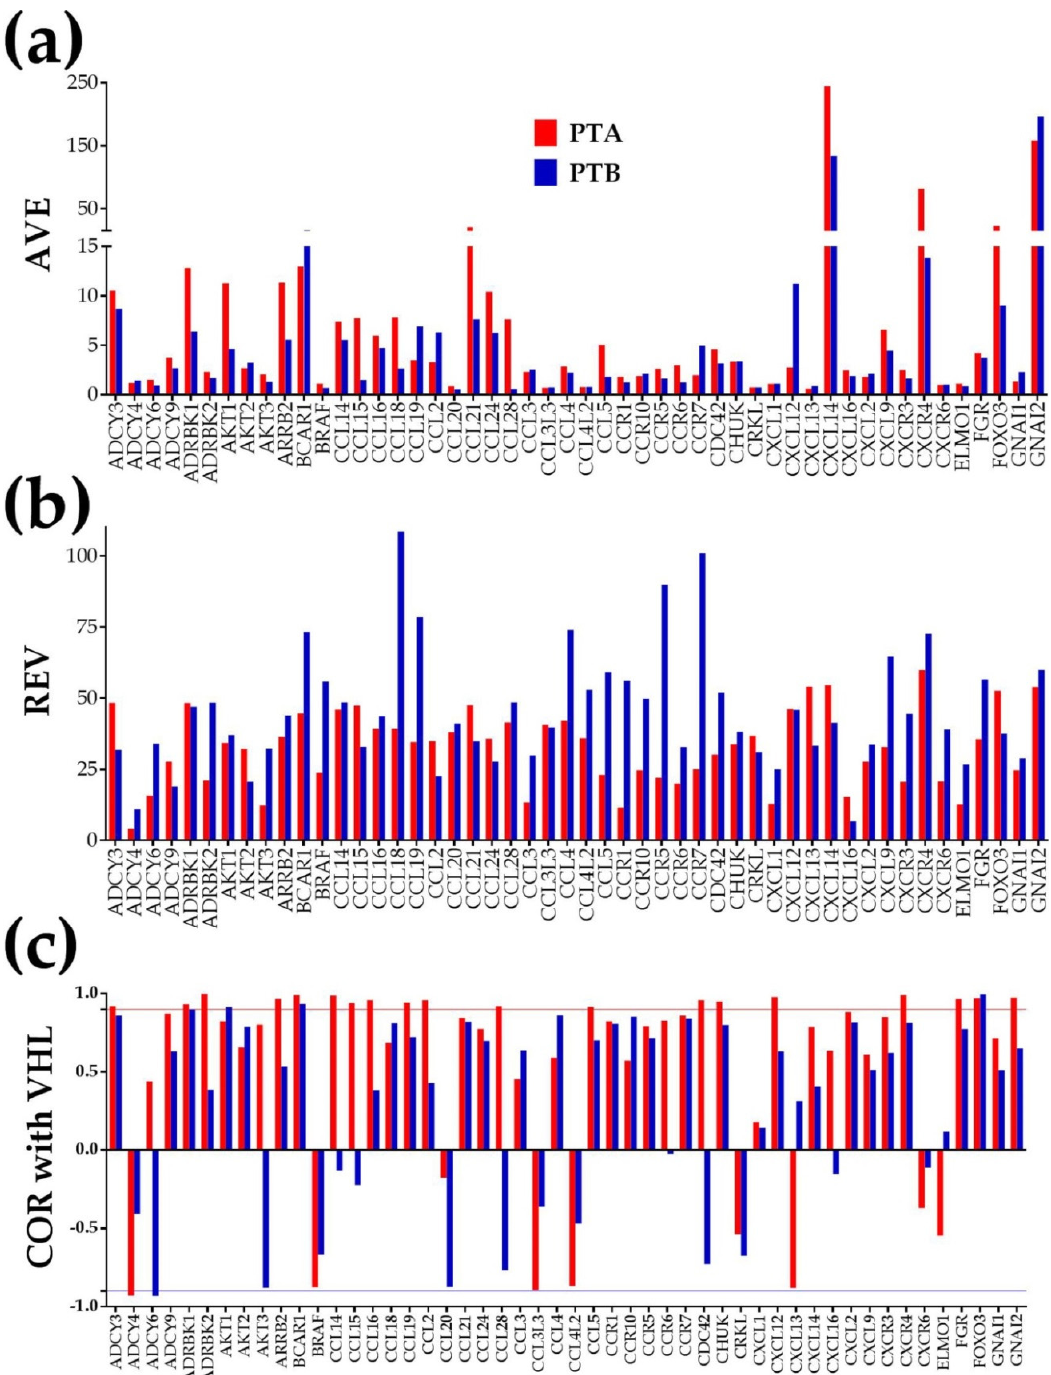
Figure 1. The three independent characteristics of the first 50 alphabetically ordered chemokine signaling genes in the two profiled cancer nodules (PTA and PTB). ( a ) AVE = average expression level; ( b ) REV = relative expression variability; ( c ) COR = correlation coefficient with von Hippel–Lindau tumor suppressor, E3 ubiquitin protein ligase (VHL) Note the independence of the three characteristics in each nodule and the differences between the two nodules despite having the same Fuhrman grade and being isolated from the same (right) kidney. The horizontal lines at COR = − 0.95 and COR = 0.95 limit the correlation coefficient interval values out of which the expression coordination is statistically significant ( p < 0.05).